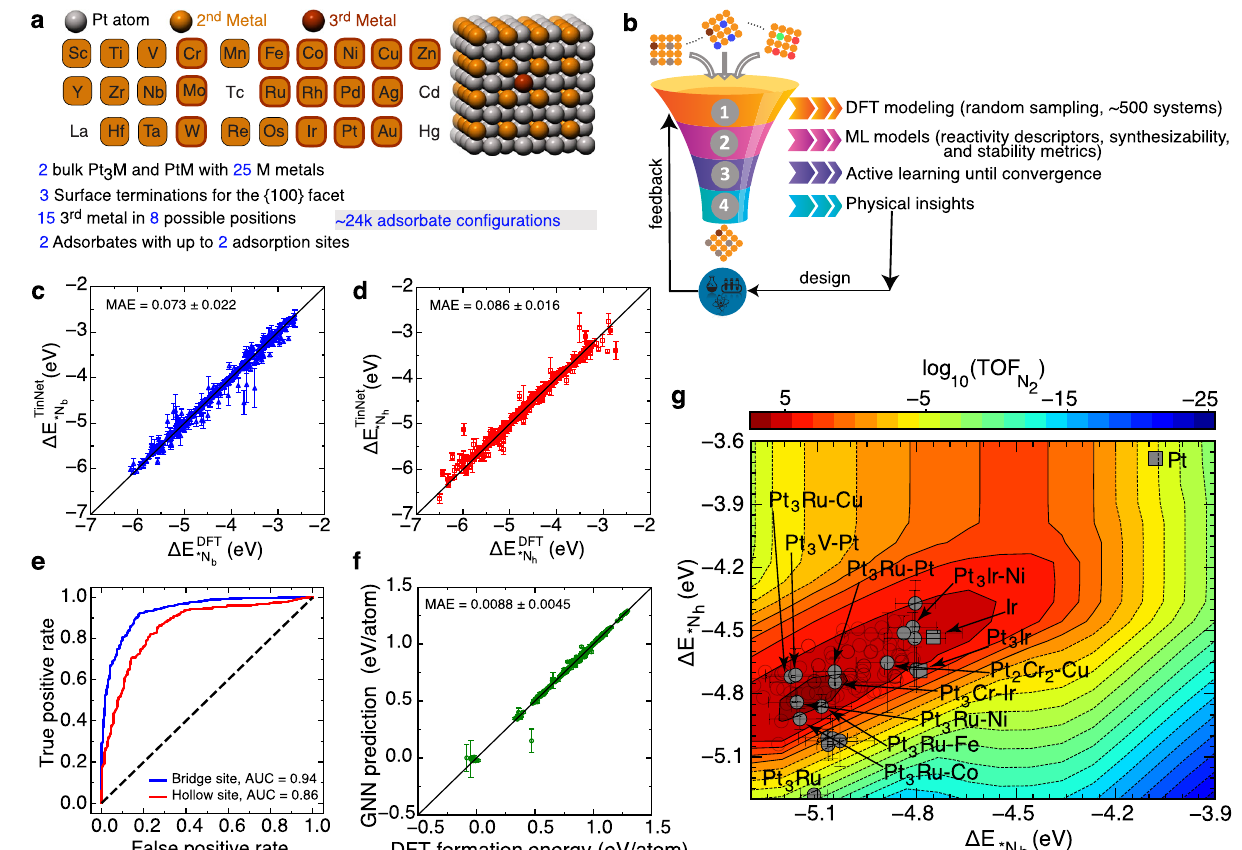
Fig. 2 | Screening of trimetallic Pt alloy electrocatalysts for AOR with graph neural networks. a The immense design space of trimetallic Pt nanocatalysts terminated with {100} facets. b An active learning work fl ow for accelerating cata- lytic materials discovery. c – f The 10-fold fi nalmodelsof graphneuralnetworks for predictingsitereactivity,surfacestability,andcatalystsynthesizabilitydescriptors. g The AOR activity map at 0.3V vs. RHE with solid markers showing promising